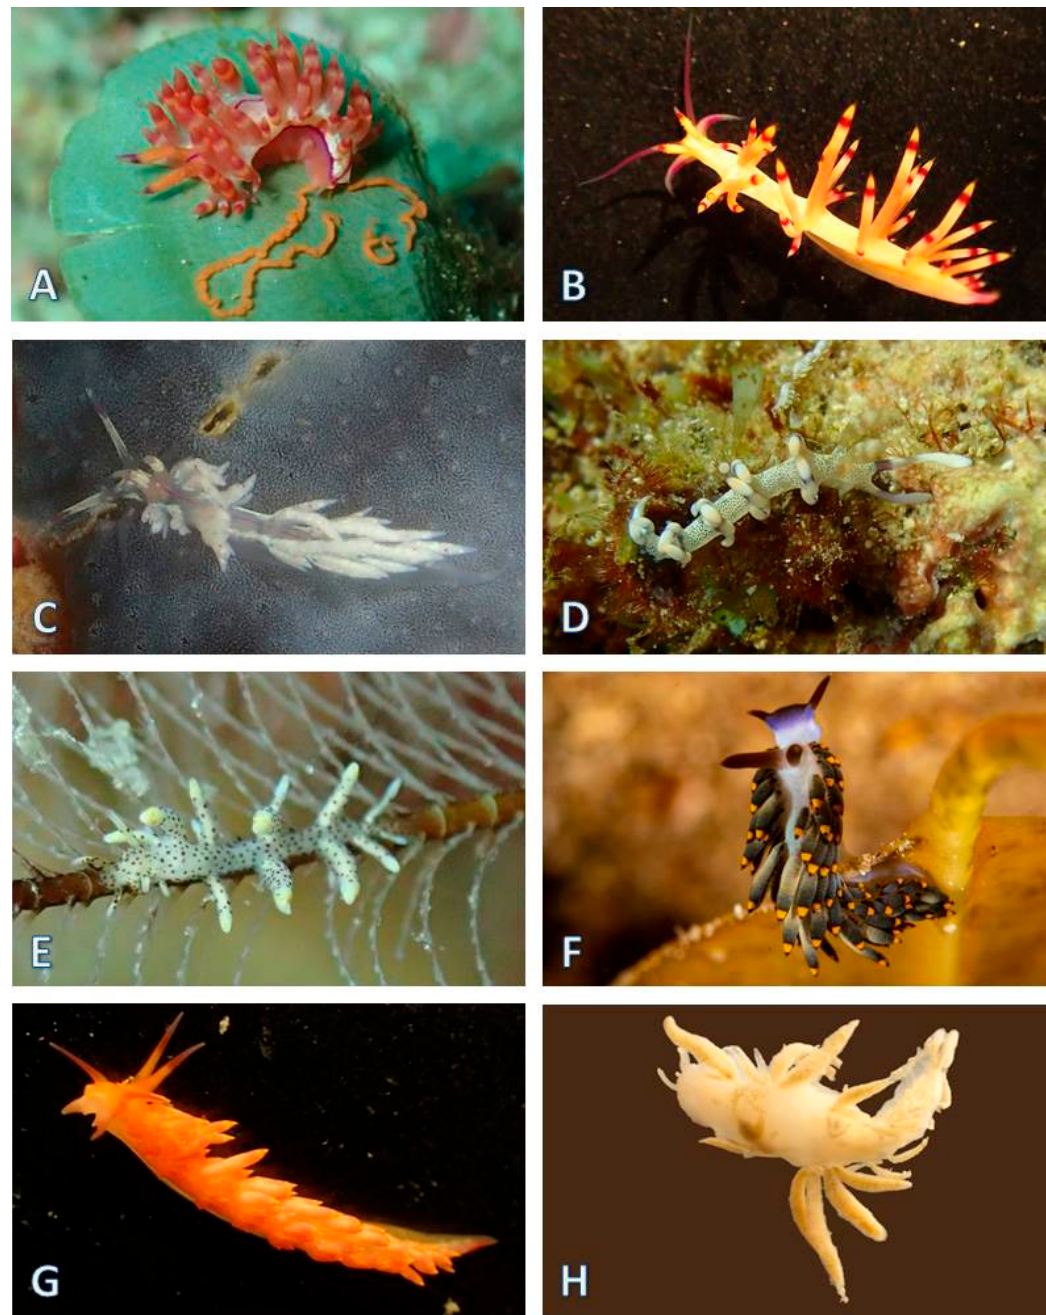
Figure 21. Nudibranchia Cladobranchia: ( A ) Coryphellina rubrolineata, Flru17Ba-1 ; ( B ) Flabellina sp.